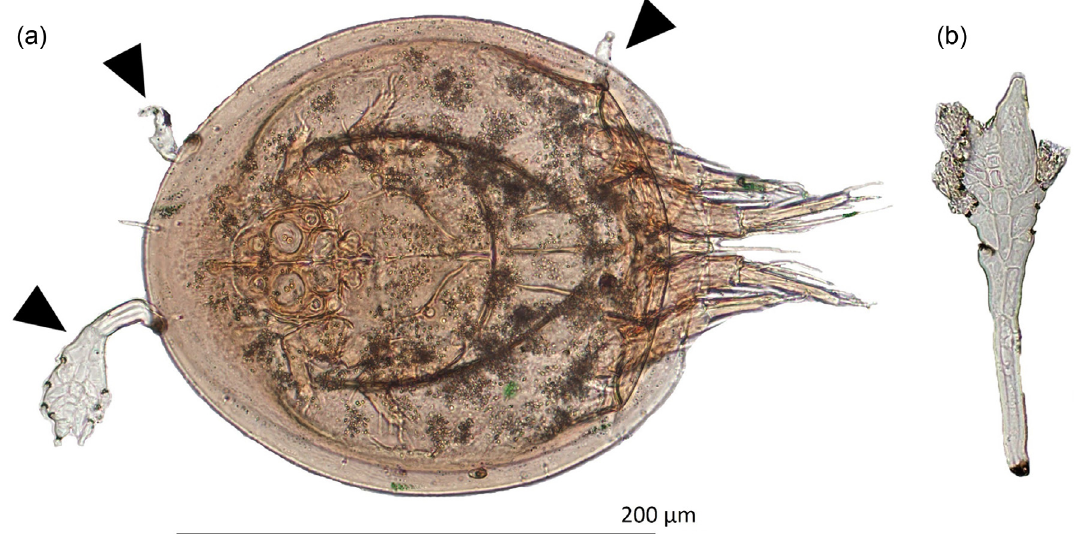
Figure 2. Rickia wasmannii . (a): Infected Acaridae deutonymph with three immature R. wasmannii thalli attached (marked). (b): Mature thallus from a Myrmica scabrinodis ant host. Scale bar = 200 l m.